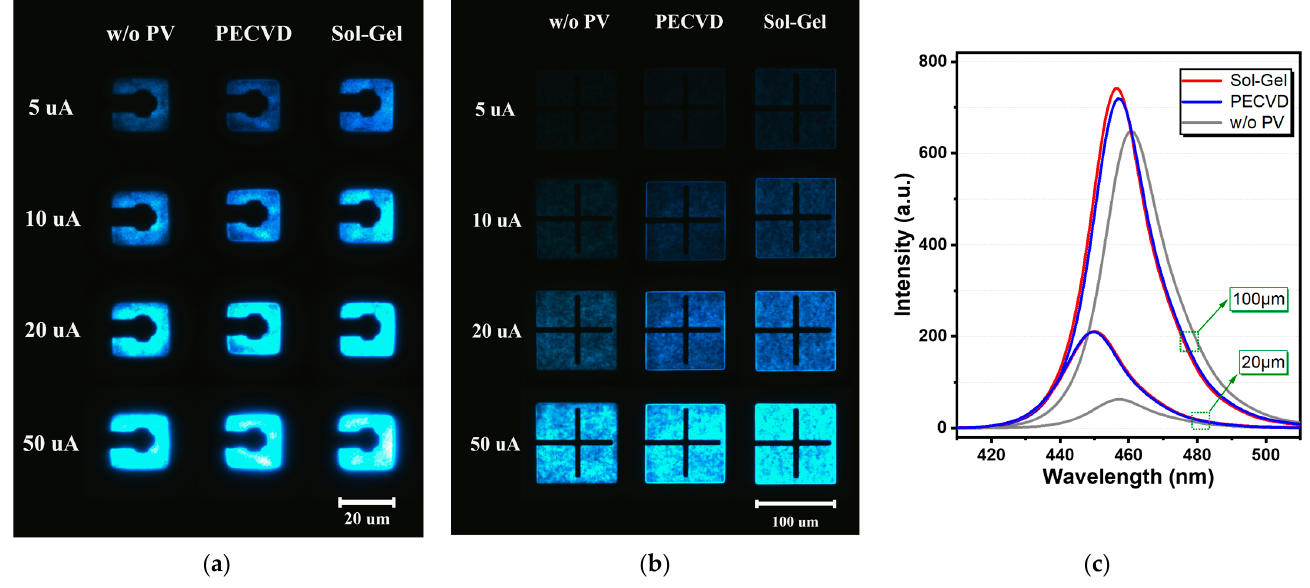
Figure 2. ( a , b ) EL emission images of S1, S2, and S3 for ( a ) 20 × 20 μ m and ( b ) 100 × 100 μ m; ( c ) EL spectrum of S1, S2, and S3 for 20 × 20 μ m (at 50 A/cm 2 ) and 100 × 100 μ m (at 10 A/cm 2 ). ( c ) EL spectrum of S1, S2, and S3 for 20 × 20 µ m (at 50 A/cm 2 ) and 100 × 100 µ m (at 10 A/cm 2